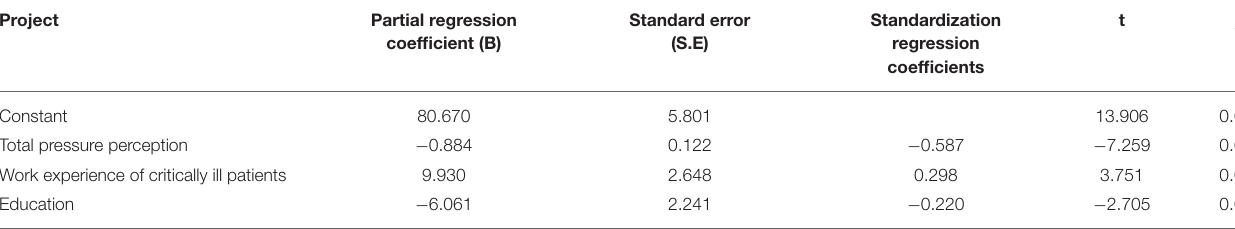
TABLE 2 | Results of multiple stepwise regression of influencing factors of